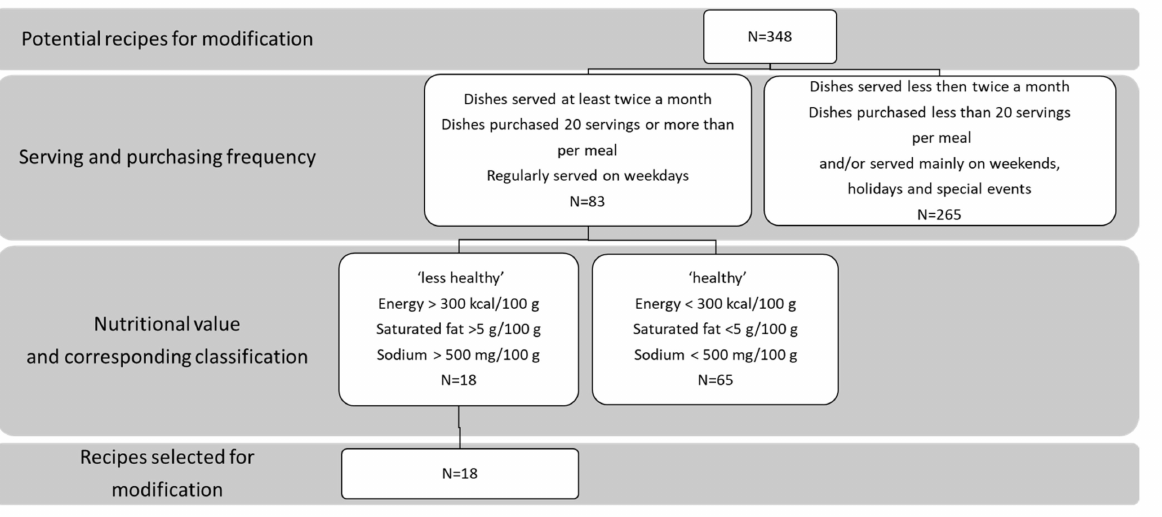
Figure 1. Algorithm for choosing recipes for